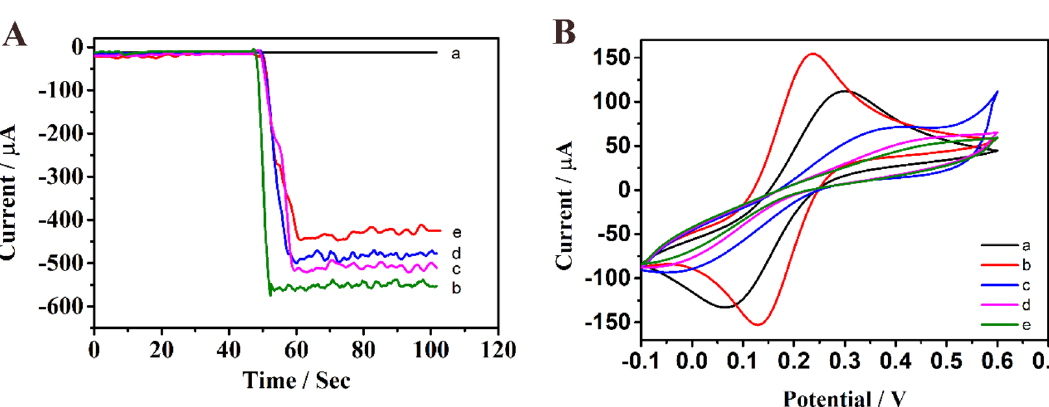
Figure 3. ( A ) The i-t curves of different coating stage (i-t curve was recorded at − 0.4 V in pH 7.4 of PBS) ( B ) CV characterization of electrodes at various stages of modification in a 5 mM [Fe(CN)6] 3−/4− solution: (a) bare GCE; (b) Cu@L-Asp/Pd–Pt NPs/GCE; (c) anti-SPOP/Cu@L-Asp/Pd–Pt NPs/GCE; (d) BSA/anti-SPOP/Cu@L- Asp/Pd–Pt NPs/GCE; (e) target/BSA/anti-SPOP/Cu@L-Asp/Pd–Pt